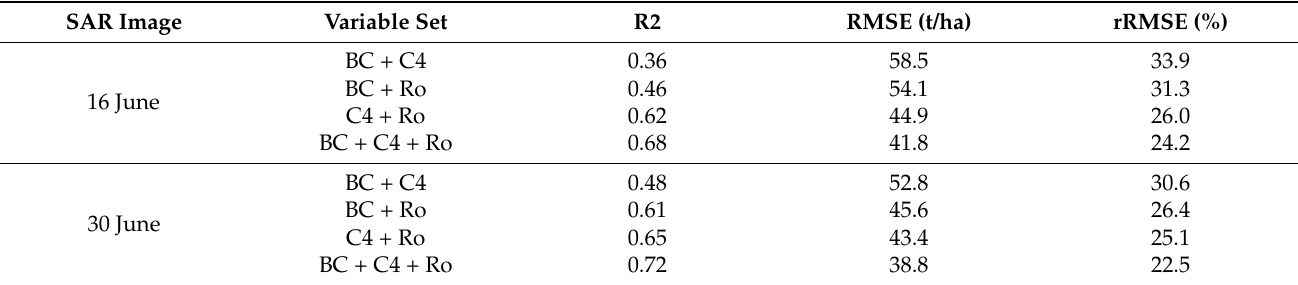
Table 6. Results of estimated AGB using combined feature sets.